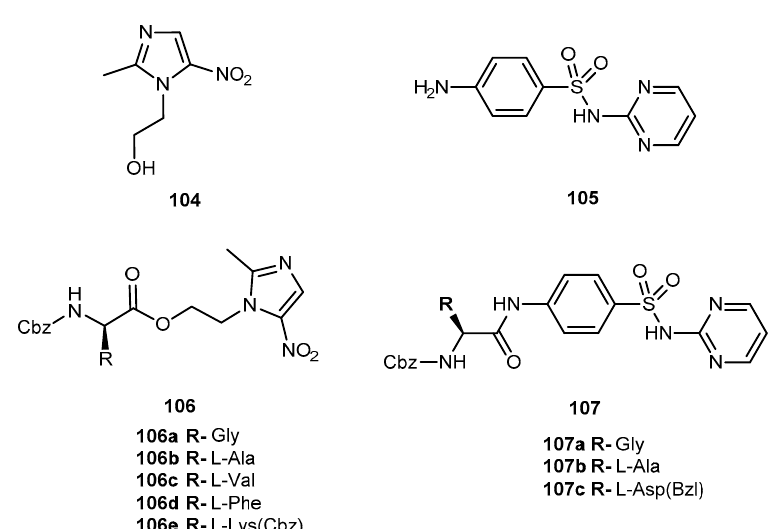
Figure 44. Structures of metronidazole ( 104 ) and its conjugates ( 106a – e) and sulfadiazine ( 105 ) and its conjugates ( 107a – c ).